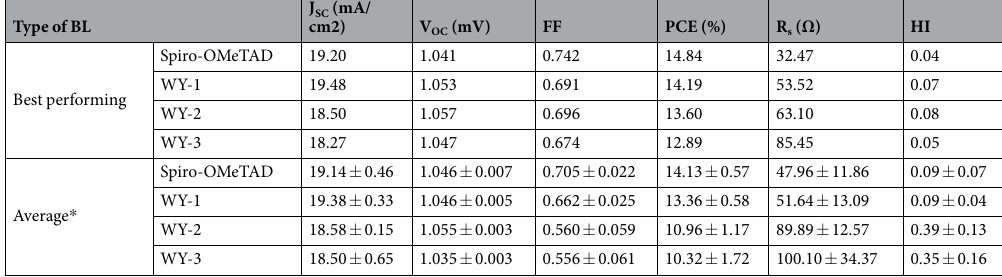
Table 2. Photovoltaic parameters of PSCs with different hole transporting layer. Photomasks (0.2 × 0.5 cm 2 ) made of thin metal sheet were applied before all measurements. The hysteresis index (HI) is defined as (P max(forward scan) /P max(backward scan) ) − 1, which P max is the maximum power in I-V measurement. * These values were obtained from 6–8